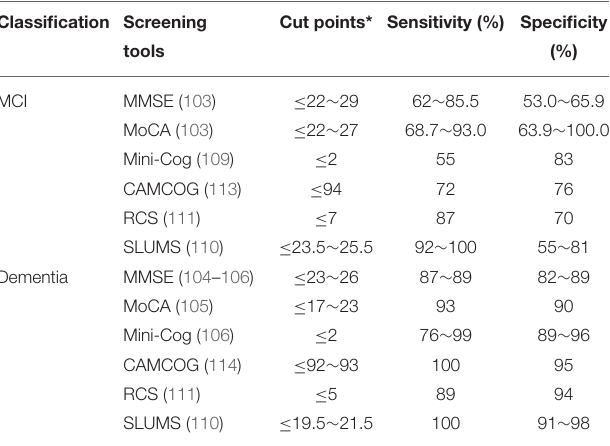
TABLE 1 | Screening tools used commonly in clinical practice for cognitive impairment (CI) diagnosis and assessment in general population. Classification